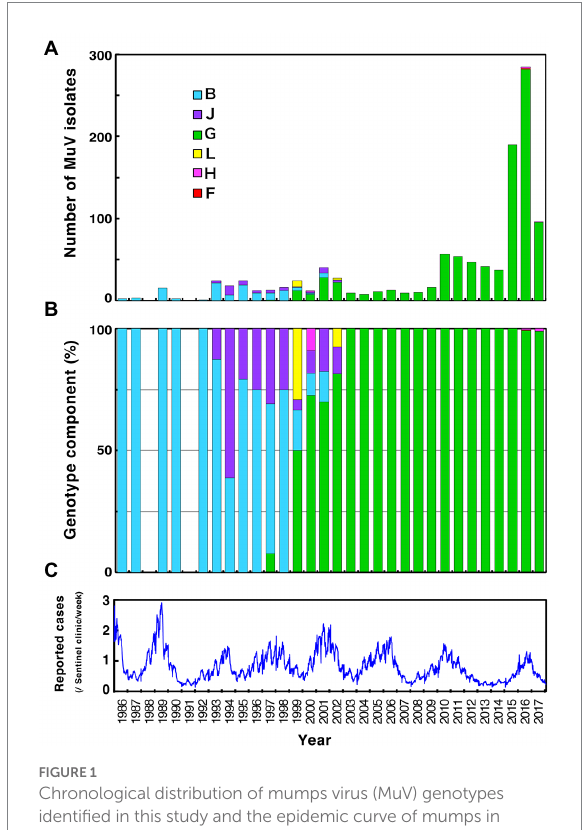
FIGURE 1 Chronological distribution of mumps virus (MuV) genotypes identified in this study and the epidemic curve of mumps in Japan from 1989 to 2017. Identified genotypes are differentiated by color. (A) The number of MuV isolates according to the year of isolation. (B) The component ratio of identified genotypes in each year. (C) The reported mumps cases from sentinel pediatric clinics nationwide each